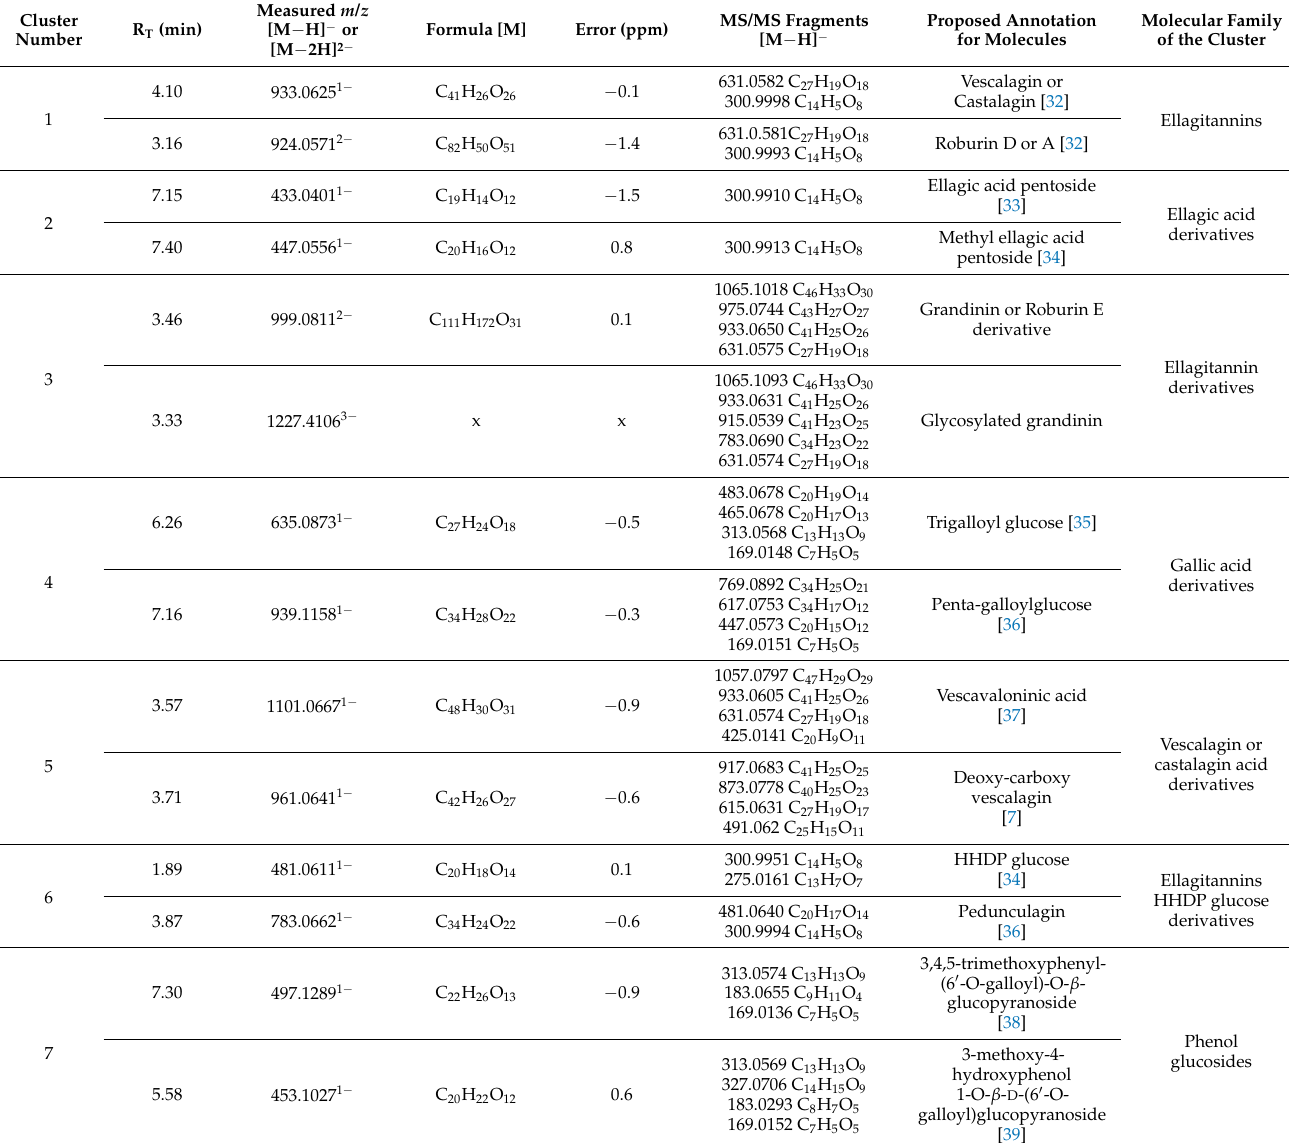
Table 1. Description of the global network that compares pedunculate oak and sessile